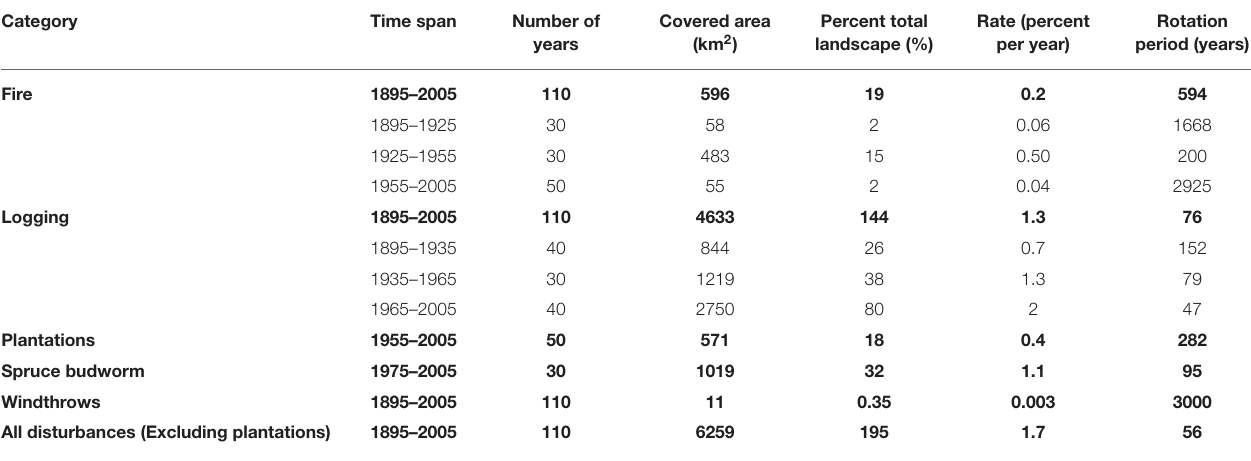
TABLE 3 | Parameters of the 20th century disturbance regime in the study